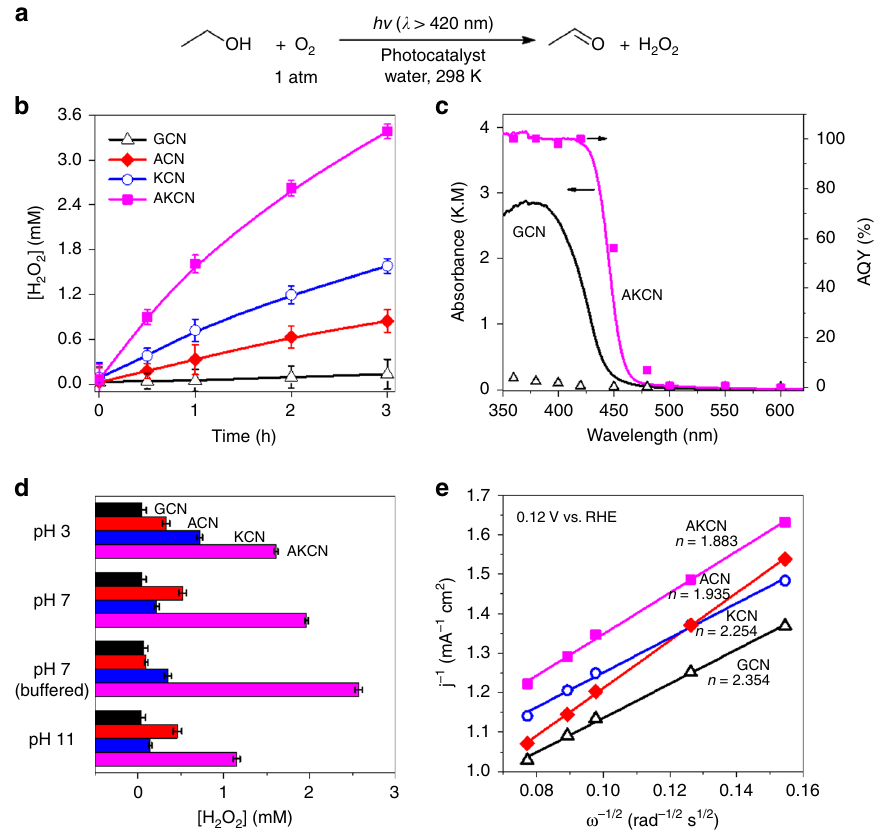
Fig. 3 Photocatalytic production of H 2 O 2 and the properties of modi fi ed GCN. a Photocatalytic reaction scheme of aerobic oxidation of alcohol coupled with H 2 O 2 production. Experimental conditions: photocatalyst (0.5 g L − 1 ) with 10 vol% EtOH under visible light illumination ( λ ≥ 420 nm), T = 25°C, water or phosphate buffer (0.1 M, pH 7). b Time pro fi les of H 2 O 2 photoproduction at pH = 3. c Apparent quantum yield (AQY) of H 2 O 2 production as a function of irradiation wavelength (0.1 M phosphate buffer, pH 7). The black open-triangle and pink solid-square represent the AQY of GCN and AKCN, respectively. d pH effect on the photocatalytic production of H 2 O 2 over pure and modi fi ed GCN in 1 h irradiation. e The Koutecky – Levich plots obtained via RDE measurements in KOH (pH 13) solution with continuous O 2 purging at 0.12 V (vs. RHE). The error bar represents the standard deviation from the repeated experiment after three times. Source data are provided as a Source Data fi